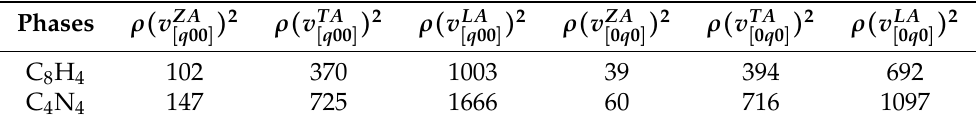
Table 4. The elastic constants in GPa unit calculated from the group velocities of acoustic phonons at q =